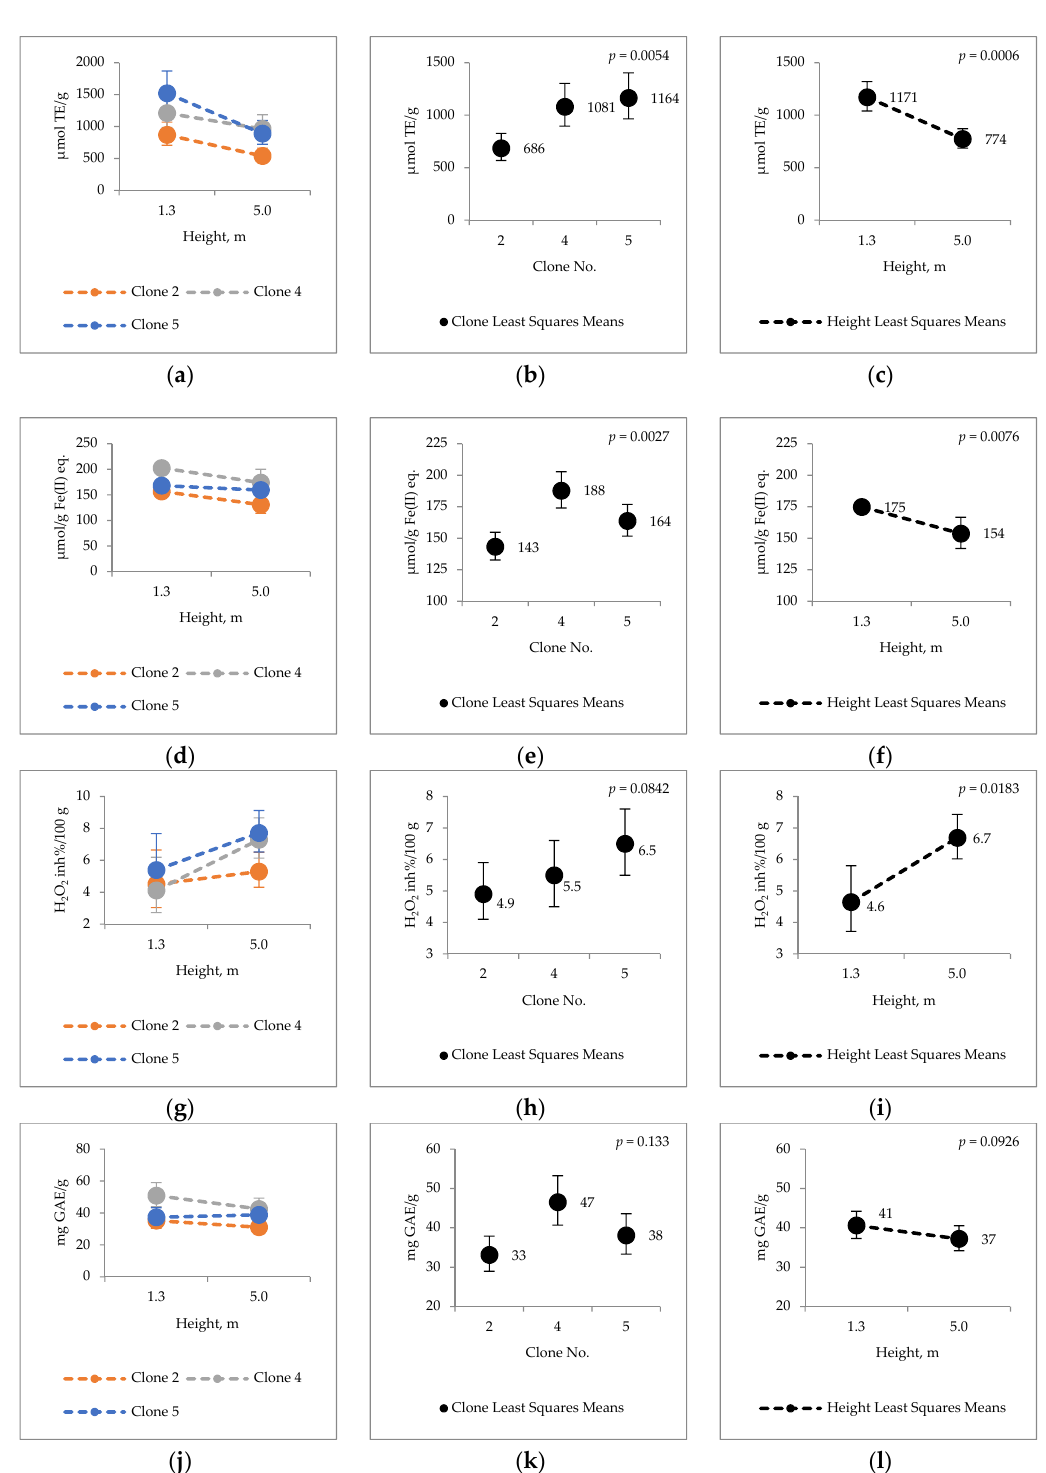
Figure 4. Hot water extract antioxidative capacity ( a – c ) ORAC µmol TE/g; ( d – f ) FRAP µmol/g Fe(II) eq.; ( g – i ) H 2 O 2 scavenging H 2 O 2 inh % per 100 g; ( j – l ) Total phenolic content mg GAE/g.